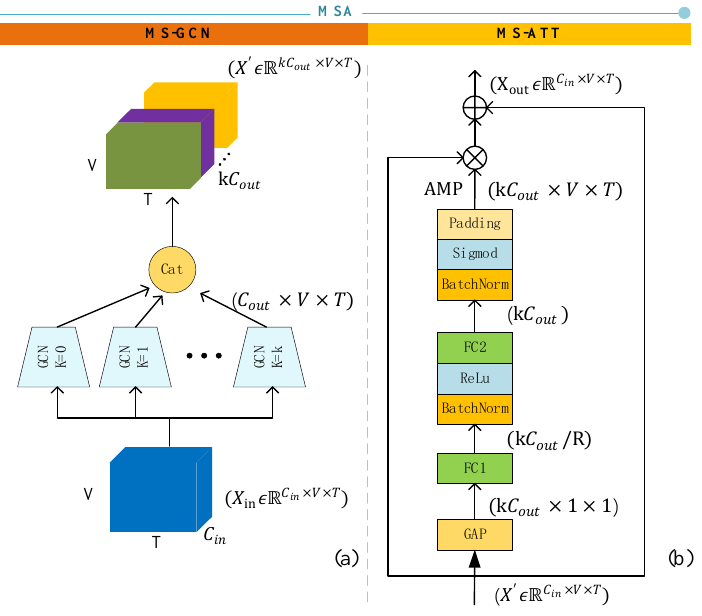
Figure 3. The structure of MSA. ( a ) The structure of MS-GCN, which uses k parallel GCNs to extract features of different levels and concatenate them on the channel layer; ( b ) The structure of MS-ATT, fist perform global average pooling(GAP) on X (cid:48) and turn its dimension into ( k C out × 1 × 1 ) . AMP means the attention map, which contains attention information of different scales “ ⊕ ” means add operation, “ ⊗ ” means matrix dot product